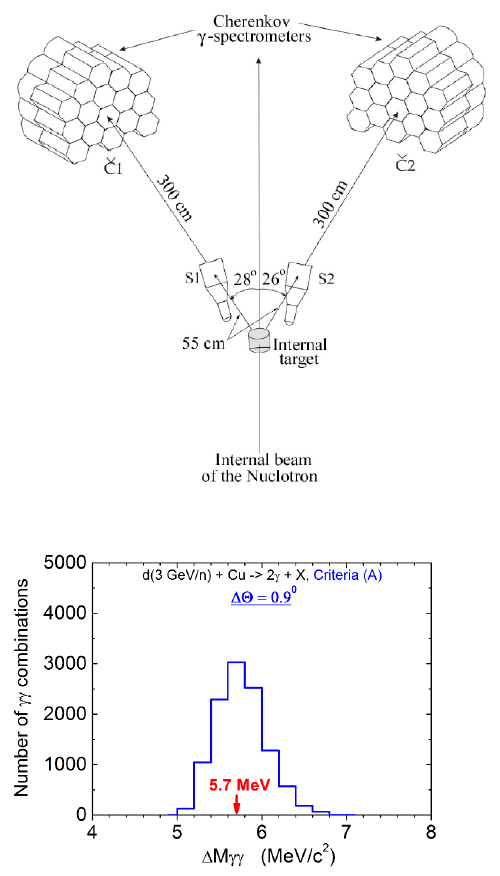
Fig. 3. The following selection criteria were used (criteria (A)): (i) the energies of